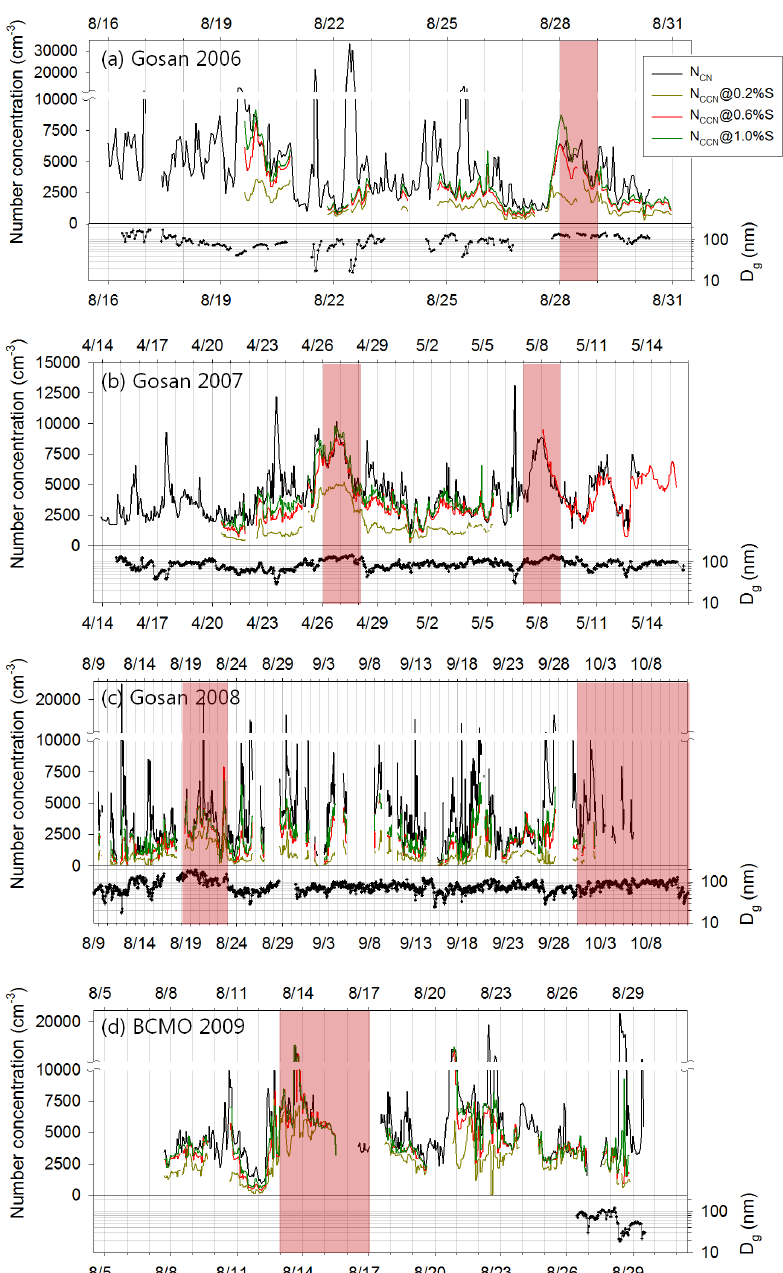
Fig. 6. Time plots of measured N CN , N CCN and D g for each campaign. Pollution periods are shaded in